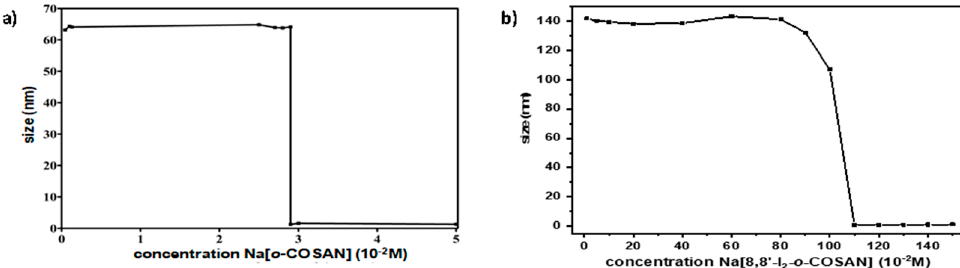
Figure 2. DLS studies of ( a ) Na[ o ‐ COSAN]: concentration range 1–50 mM; ( b ) Na[8,8 ′‐ I 2 ‐ o ‐ COSAN]: concentration range 5–150 mM in aqueous solution.